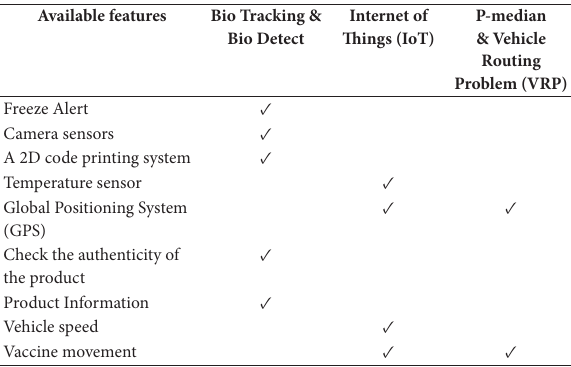
Table 3. Comparison of the Types of COVID-19 Vaccine Dis- tribution Technologies (PATH 2013; Mahardika et al. 2014; Lel- oglu 2017; Darwish et al. 2019; Jarrett et al. 2020; Forni et al. 2021; PT Bio Farma (Persero)